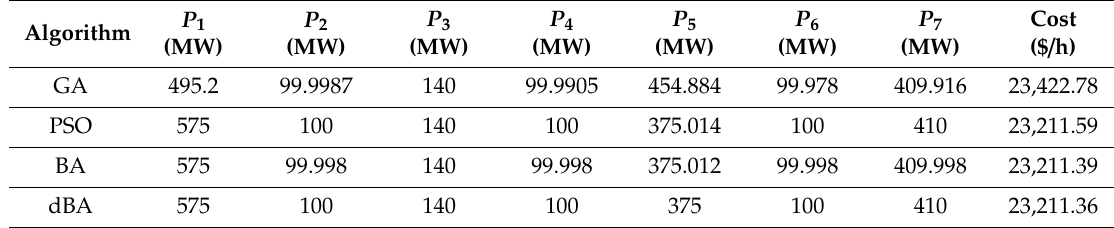
Table 5. Cost comparison for 1800 MW demand without renewables.